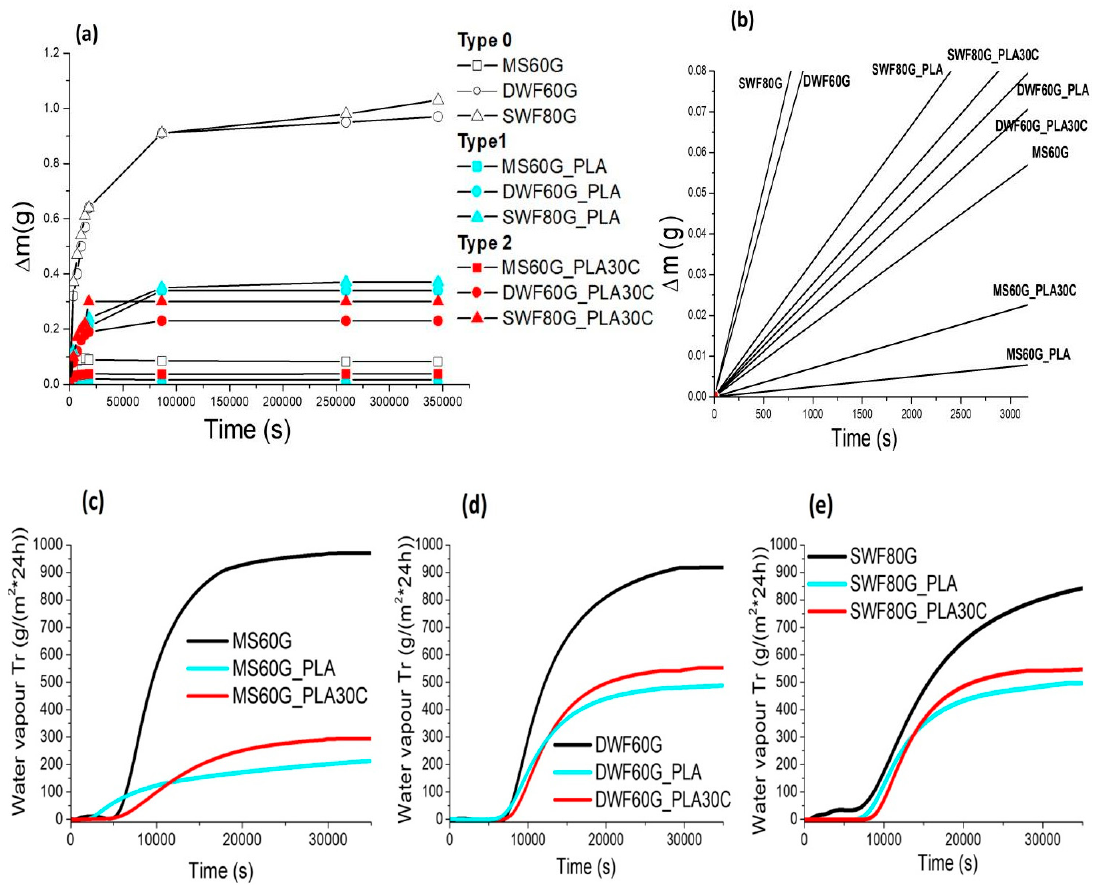
Figure 2. Hygroscopic absorption curves as a function of time ( a ) and a time magnification related to the first linear section ( b ); water vapor permeability curves of MS-based bio-films ( c ), DWF-based bio-films ( d ) and SWF-based bio-films ( e ). Table 4. Hygroscopic and water vapor permeability data of maize starch (MS)-based, durum waste